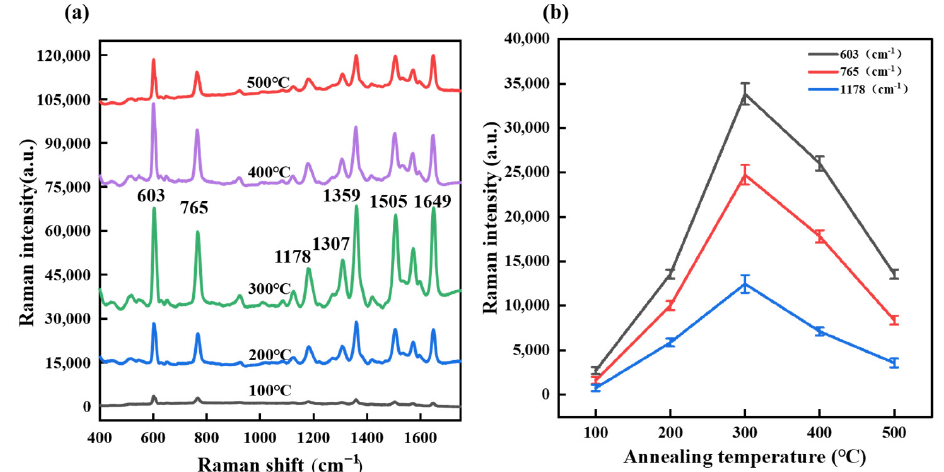
Figure 3. ( a ) The Raman spectra of the Au–Ag composite nanostructures with a series of annealing temperature from 100 °C to 500 °C. ( b ) The Raman intensities at 603 cm − 1 (black line), 765 cm − 1 (red line), and 1178 cm − 1 (blue line) peaks as a function of the annealing temperature.